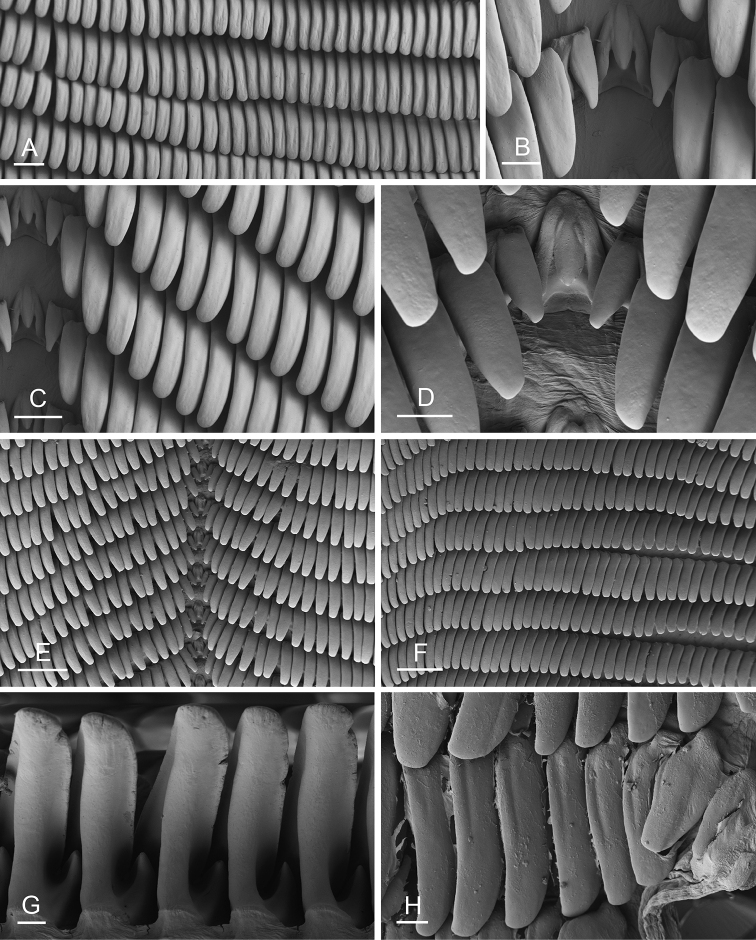
Radula, Peronia
peroniiA–C Papua New Guinea [5476] (MNHN-IM-2013-16260) D–H Guam [5840] (MNHN-IM-2019-1609) A lateral teeth B rachidian and innermost lateral teeth C rachidian and innermost lateral teeth D rachidian and innermost lateral teeth E rachidian and lateral teeth F lateral teeth G lateral teeth, frontal view H outermost lateral teeth. Scale bars: 100 μm (A), 40 μm (B, D), 80 μm (C), 200 μm (E, F), 100 μm (G, H).